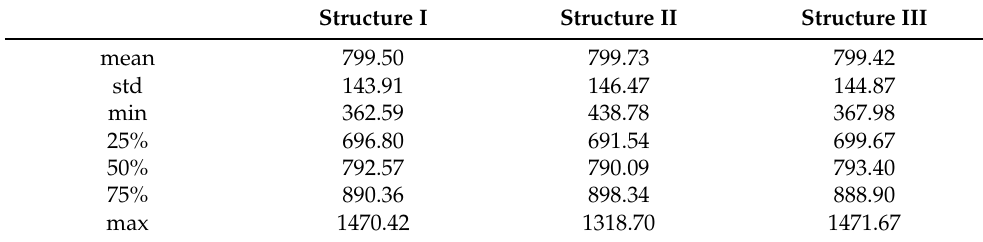
Table 1. Statistical analysis of thermal fluctuations in VASP MD